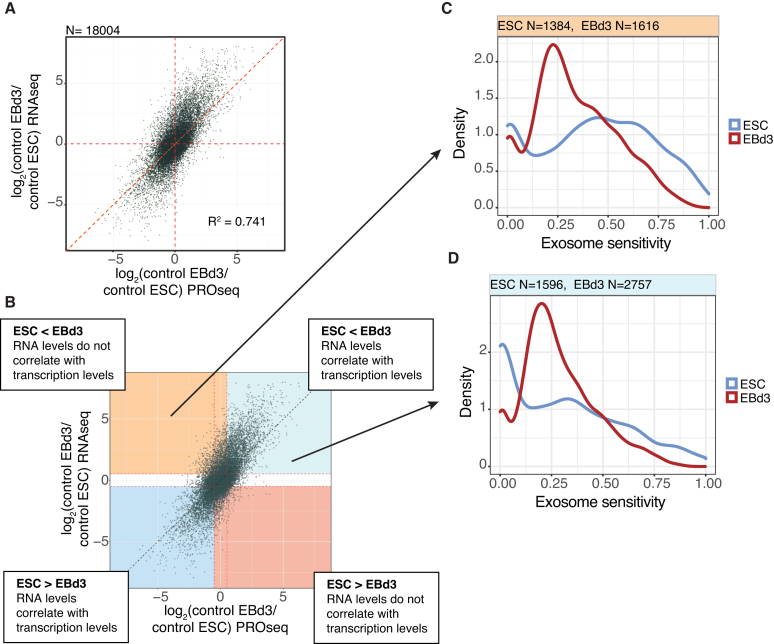
Contribution of transcription and exosome decay to RNA changes. (A) Scatter plot of log2 fold changes between RNAseq values of all GENCODE annotated genes in EBd3 versus ESC samples (y-axis) against log2 fold changes between PROseq values in EBd3 versus ESC samples (x-axis). Pearson's R square value is indicated. Red dashed lines indicate x = 0, y = 0 and y = x. (B) Same plot as in (A) but defining subsets of the data based on up- and down-regulation between EBd3 versus ESC, and whether RNAseq and PROseq value changes correlate positively (blues) or not (red-orange), as indicated by callouts. (C) Density plots of RNAseq-calculated exosome sensitivities from ESC (blue line) and EBd3 (red line), analyzing transcripts downregulated in ESC that have no correlation between RNAseq and PROseq changes (top-left quadrant from (B). (D) Density plots as in (C) but analyzing transcripts downregulated in ESC that have correlating RNAseq and PROseq changes (top-right quadrant from (B)). The number of genes/RNAs (N) included is indicated above each panel.